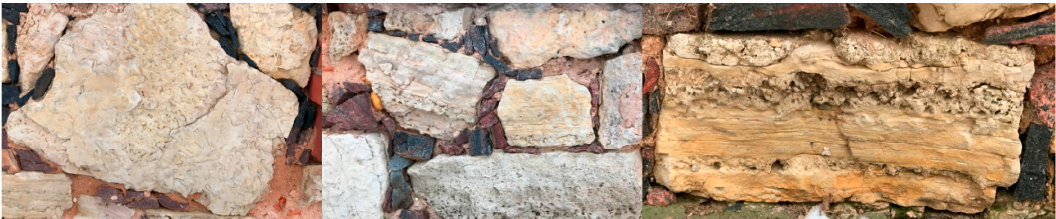
Figure 1. Structural patterns of dolomite stones in the external wall of the building. The walls have a thickness of 0.60 m (ground floor and basement) and 0.45 m (1st floor). Brick columns are built in the corners and around the windows as a frame. The interior side of the external walls has an originally installed plaster layer. In 2006, after full-scale roof reconstruction, two dormers were added on the west and east sides of the house (see Figure